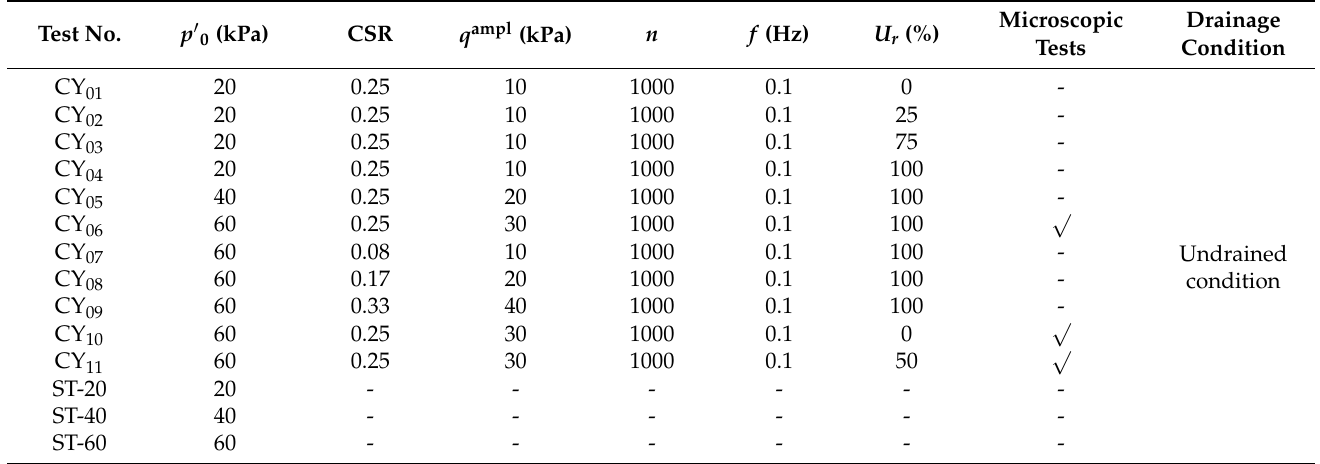
Table 2. Summary of cyclic triaxial